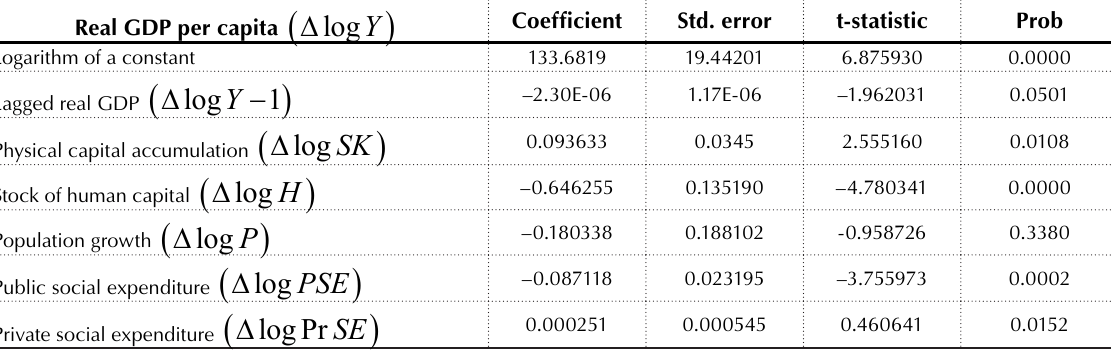
Table 5. Fixed Effect Regression for the logarithm of real GDP per capita and the logarithm of socio- economic